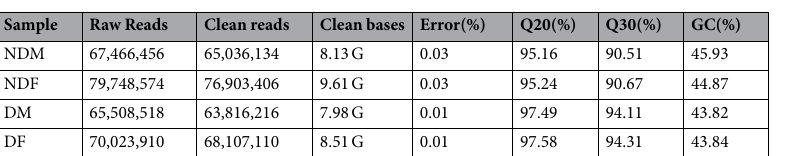
Table 1. Output statistics from Illumina sequencing 150 bp paired end reads of the active season versus dormancy adult life history stages of C. ciliata . NDM, Non-dormant male; NDF, Non-dormant female; DM, Dormant male; DF, Dormant female.